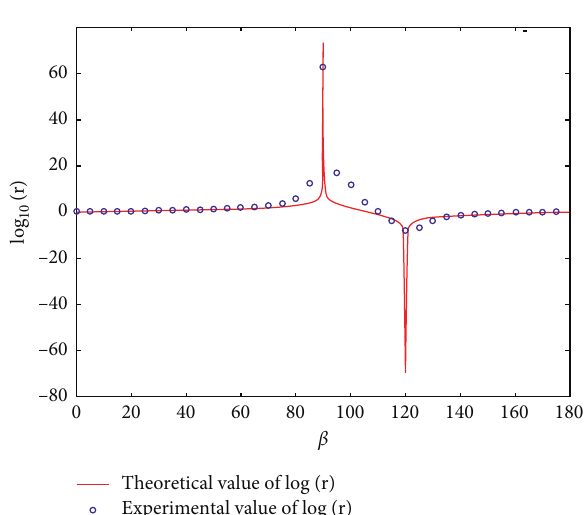
Figure 3: Theoretical and practical relationship between the value ( r ) and third polarizer rotation angle β when α � 30 ° . Their of log 10 error is within an acceptable range, and the error is mainly due to the nonlinear coefficient k ( α , β ) and the limited dynamic range of the charge-coupled device